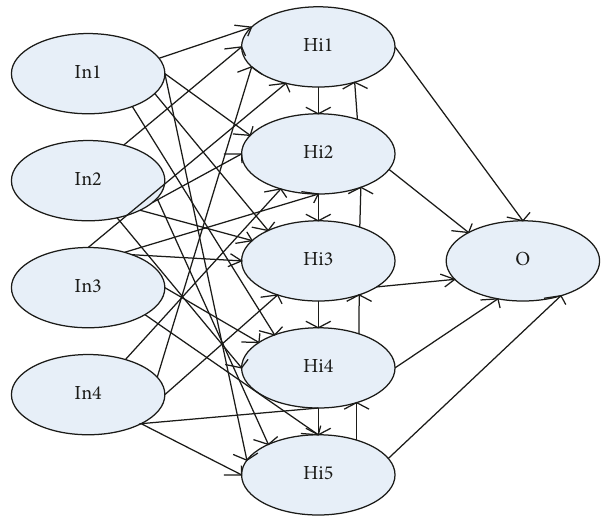
Figure 5: Recurrent neural network model